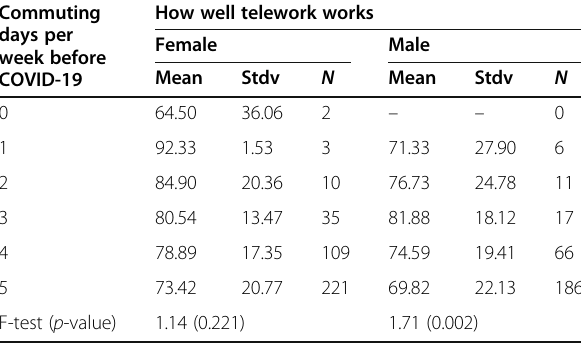
Table 5 Responses to the Question ‘ How Well Do You think Teleworking Works for You Now, During COVID-19 ” (Rating 1 – 100)? ’